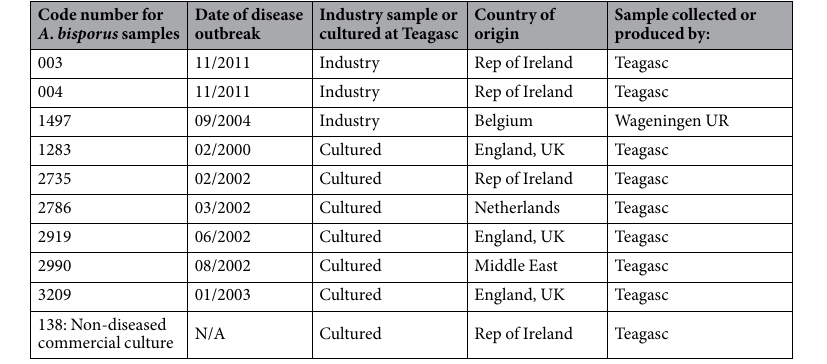
Table 4. Details of samples used for Next Generation